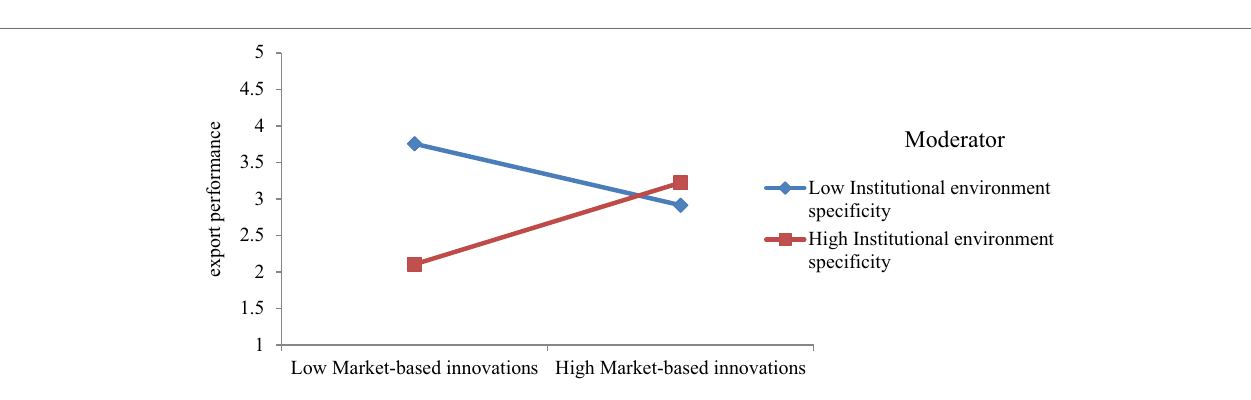
FIGURE 6 | Interaction of model